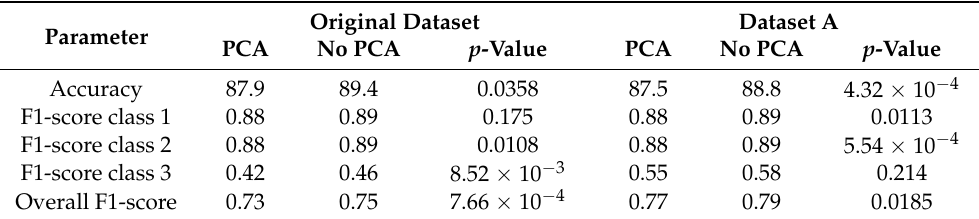
Table 4. Overview of the results for the 4 s time window for the original dataset and dataset A. Here, a comparison was made between applying Principal Component Analysis (PCA) or not applying PCA (No PCA). The p -value is provided to show whether the two values are significantly different ( p -value < α , p -value < 0.05) or not. Significance was tested with a paired samples t -test with a two-tailed